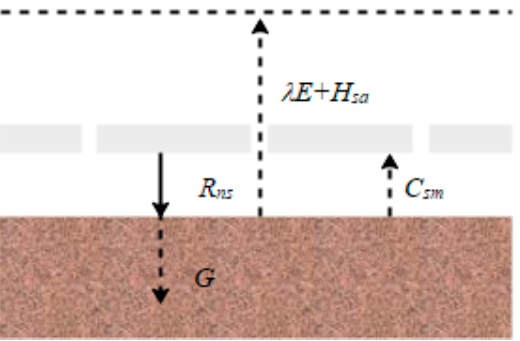
Figure 2. Schematic diagram of energy transport with perforated plastic film mulch.